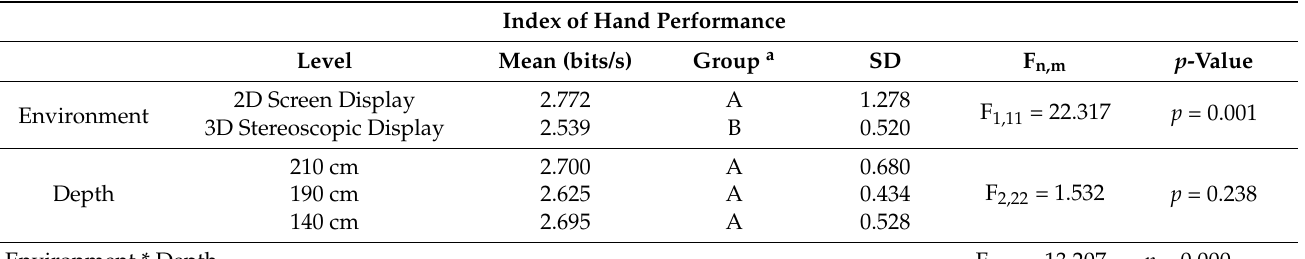
Table 11. Means, SDs, ANOVA, and Tukey HSD test results of index of motor